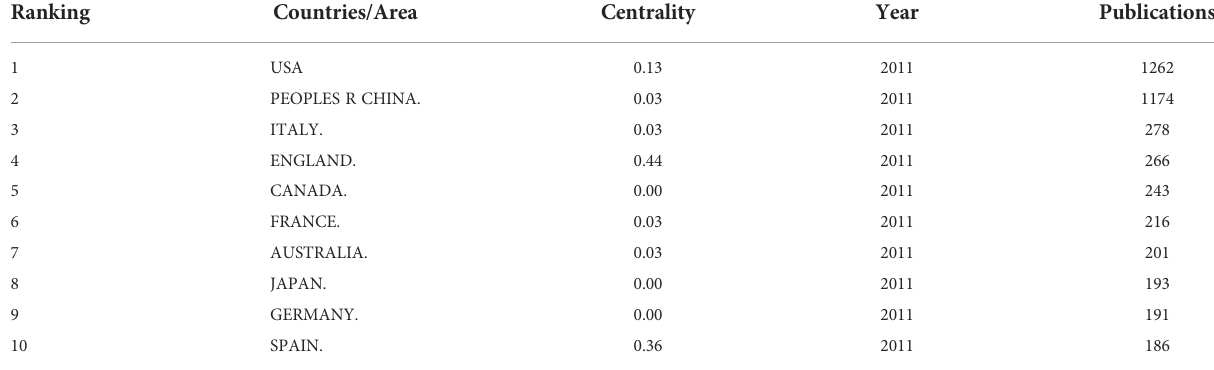
TABLE 1 Top 10 countries/regions with the most publications.